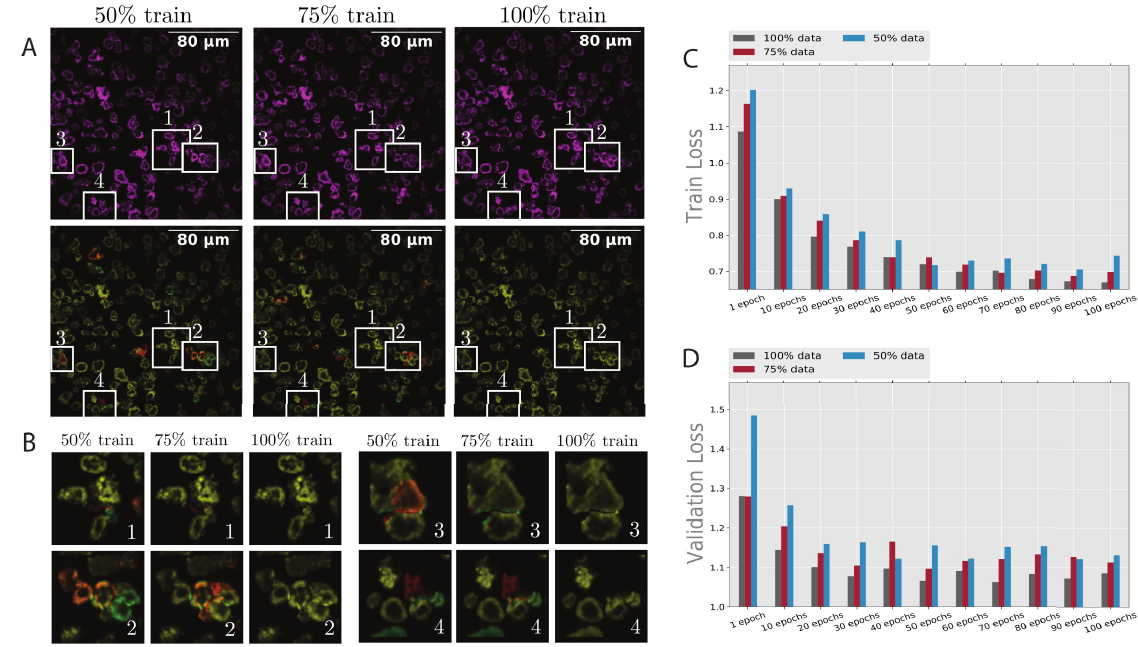
Fig 5. The comparison of the model’s loss with different sets of training data. (A) Represents a test image sample in the evaluation phase using the defined trained networks. In (B), four different zoomed areas are selected for analysis. Images with similar numbers point to the same boxes in (A). These images present the effect of having access to more training data and its role in removing discrepancies. (C) Shows the training loss, and (D) Shows the validation loss from 0 to 100 training iterations with 100% of the training data. As expected, the training loss shows a more predictable pattern than validation